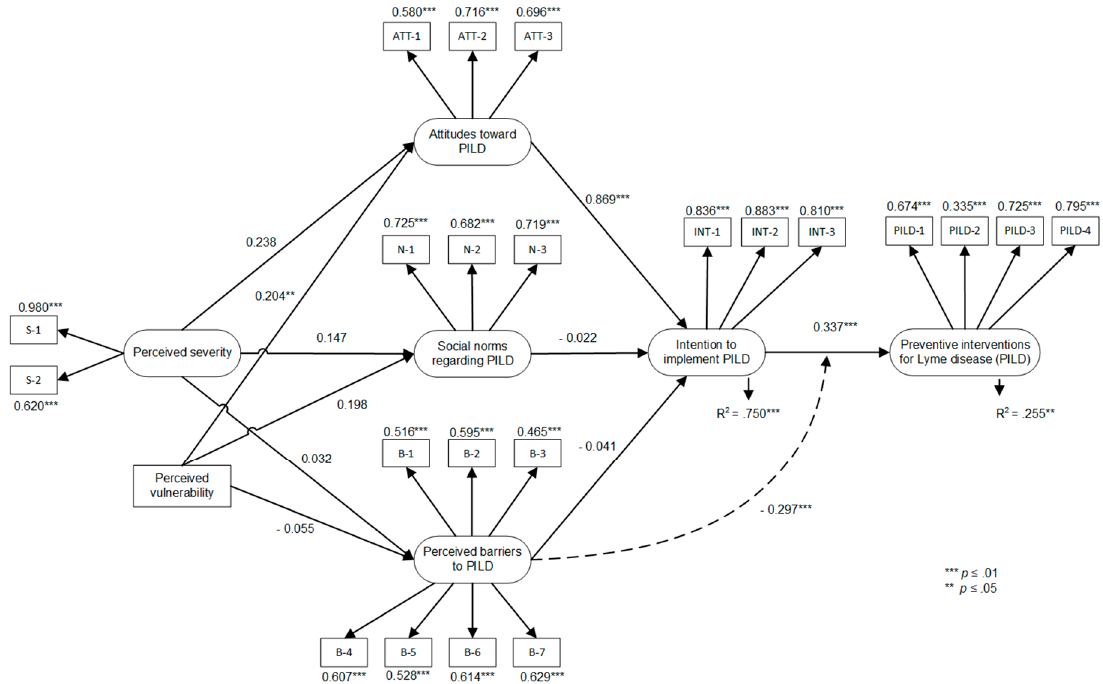
Figure 3. TPB and HBM variables predicting the implementation of preventive interventions for Lyme disease, with moderation e ff ect. Note . Correlations between predictor variables were: 0.590 *** between attitude and perceived social norms; − 0.192 between attitudes and perceived control (barriers) over the implementation of PILD; − 0.041 between social norms and perceived control (barriers) over the implementation of PILD; 0.256 ** between perceived vulnerability and perceived severity. ** p < 0.05. *** p < 0.01.